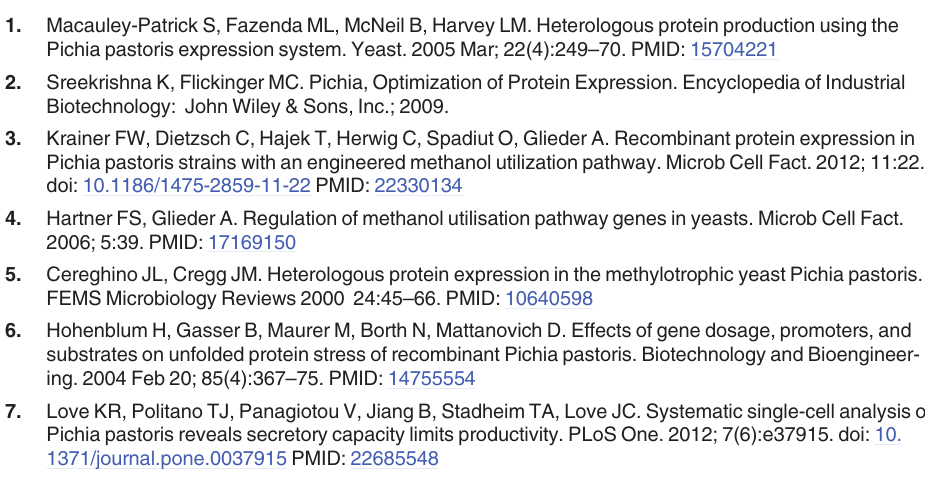
S15 Fig. KOBAS comparisons between glycolysis/gluconeogenesis gene expression levels in TRY1 -3 and GS115, 4 hours after addition of methanol. Comparisons are based on KEGG pathways. Genes where expression is significantly up-regulated (red) or down-regulated (blue) in TRY1 -3 compared to GS115 are highlighted. P pastoris genes where expression is not signifi- cantly different are highlighted in green S16 Fig. Expression levels of genes associated with protein processing in the ER. Heat maps of log 2 normalised expression levels of genes associated with protein processing in the ER, grouped according to KEGG pathways. Genes are uniquely identified by PAS (PAStoris) codes and expression was determined at 0, 2 and 4h after methanol addition in fed-batch cultures of GS115, TRY1-1 and TRY1-3. The associated trees cluster genes with similar expression profiles across all conditions. S17 Fig. Expression levels of genes associated with N-glycan biosynthesis. Heat maps of log 2 normalised expression levels of genes associated with N-glycan biosynthesis, grouped accord- ing to KEGG pathways. Genes are uniquely identified by PAS (PAStoris) codes and expression was determined at 0, 2 and 4h after methanol addition in fed-batch cultures of GS115, TRY1-1 and TRY1-3. The associated trees cluster genes with similar expression profiles across all con-